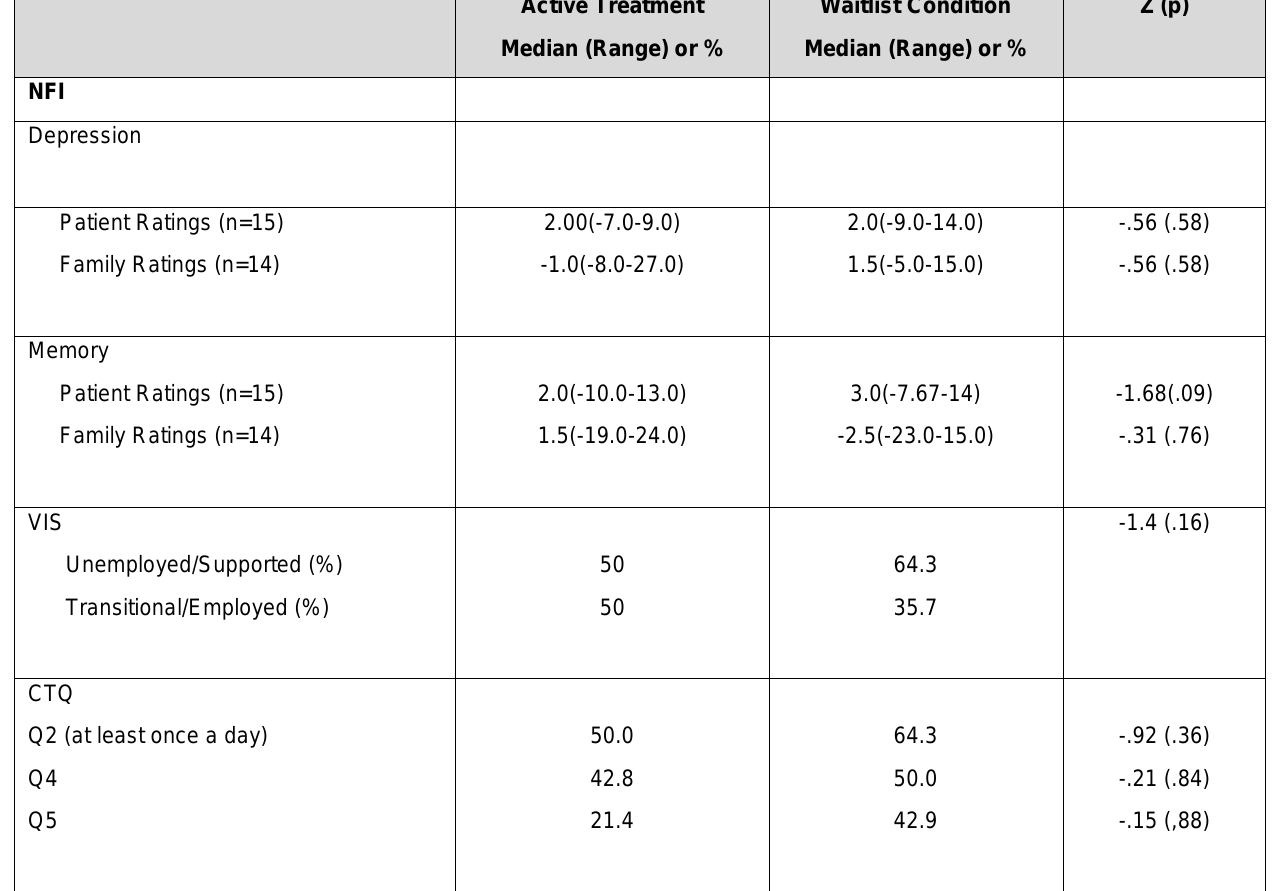
Table 4. Treatment Effect: Active Treatment vs. Waitlist Condition (N=14 a